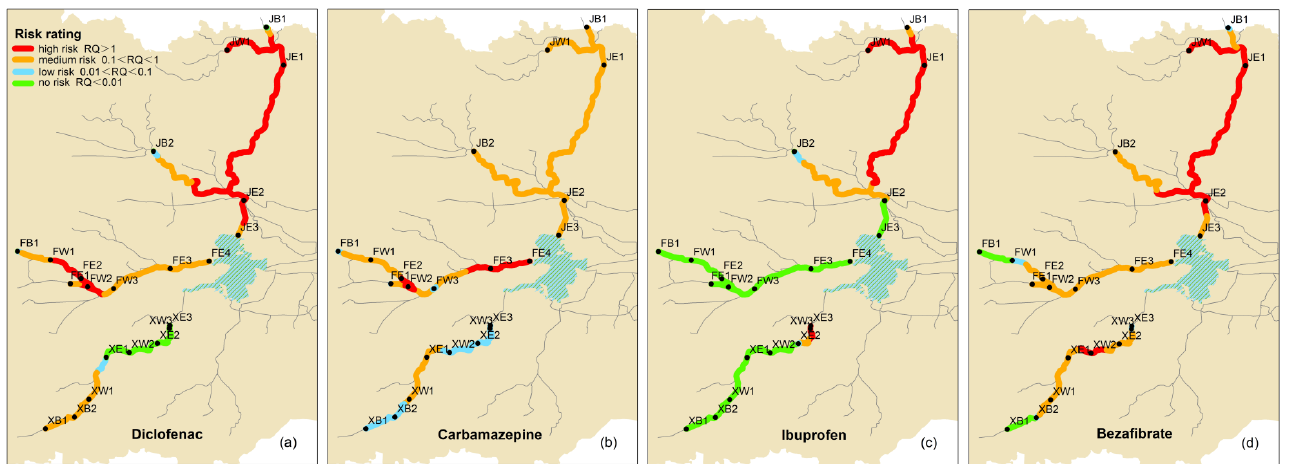
Figure 5. The ecological risk distribution of high-risk PPCPs in the Daqing River Basin. ( a ) Diclofenac, ( b ) Carbamazepine, ( c ) Ibuprofen, ( d ) Bezafibrate. The impact of the new standard’s implementation on PPCPs.